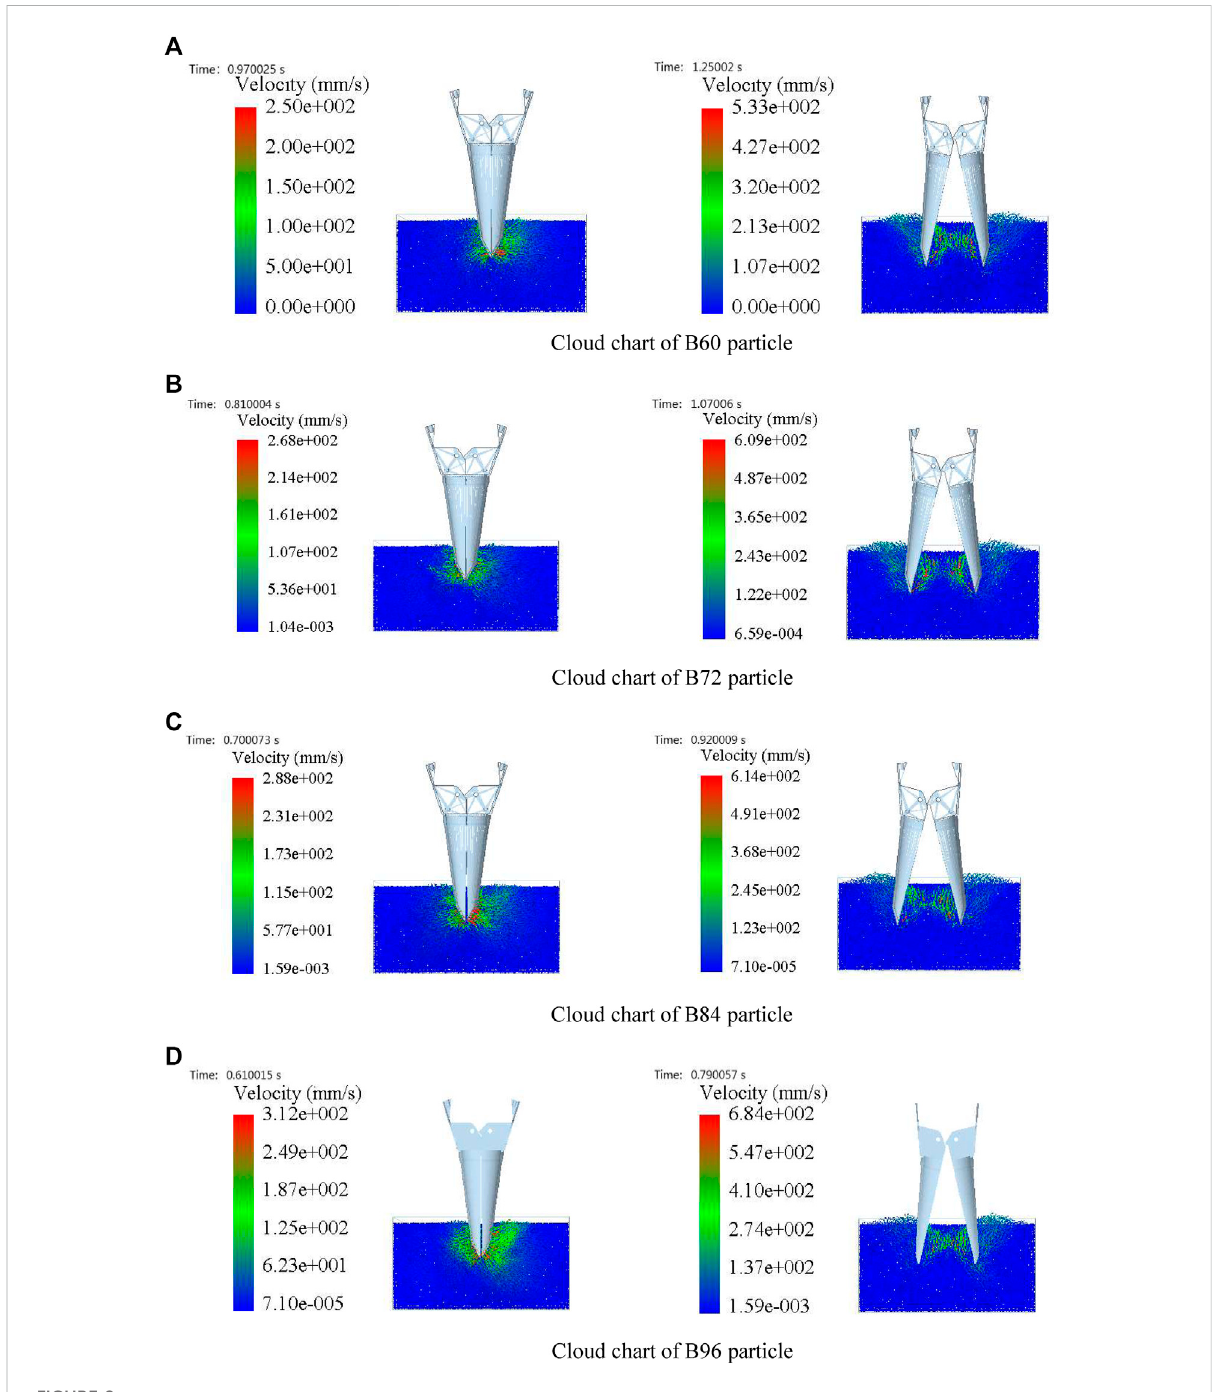
FIGURE 8 Cloud chart of particle change during the movement of a conical hanging